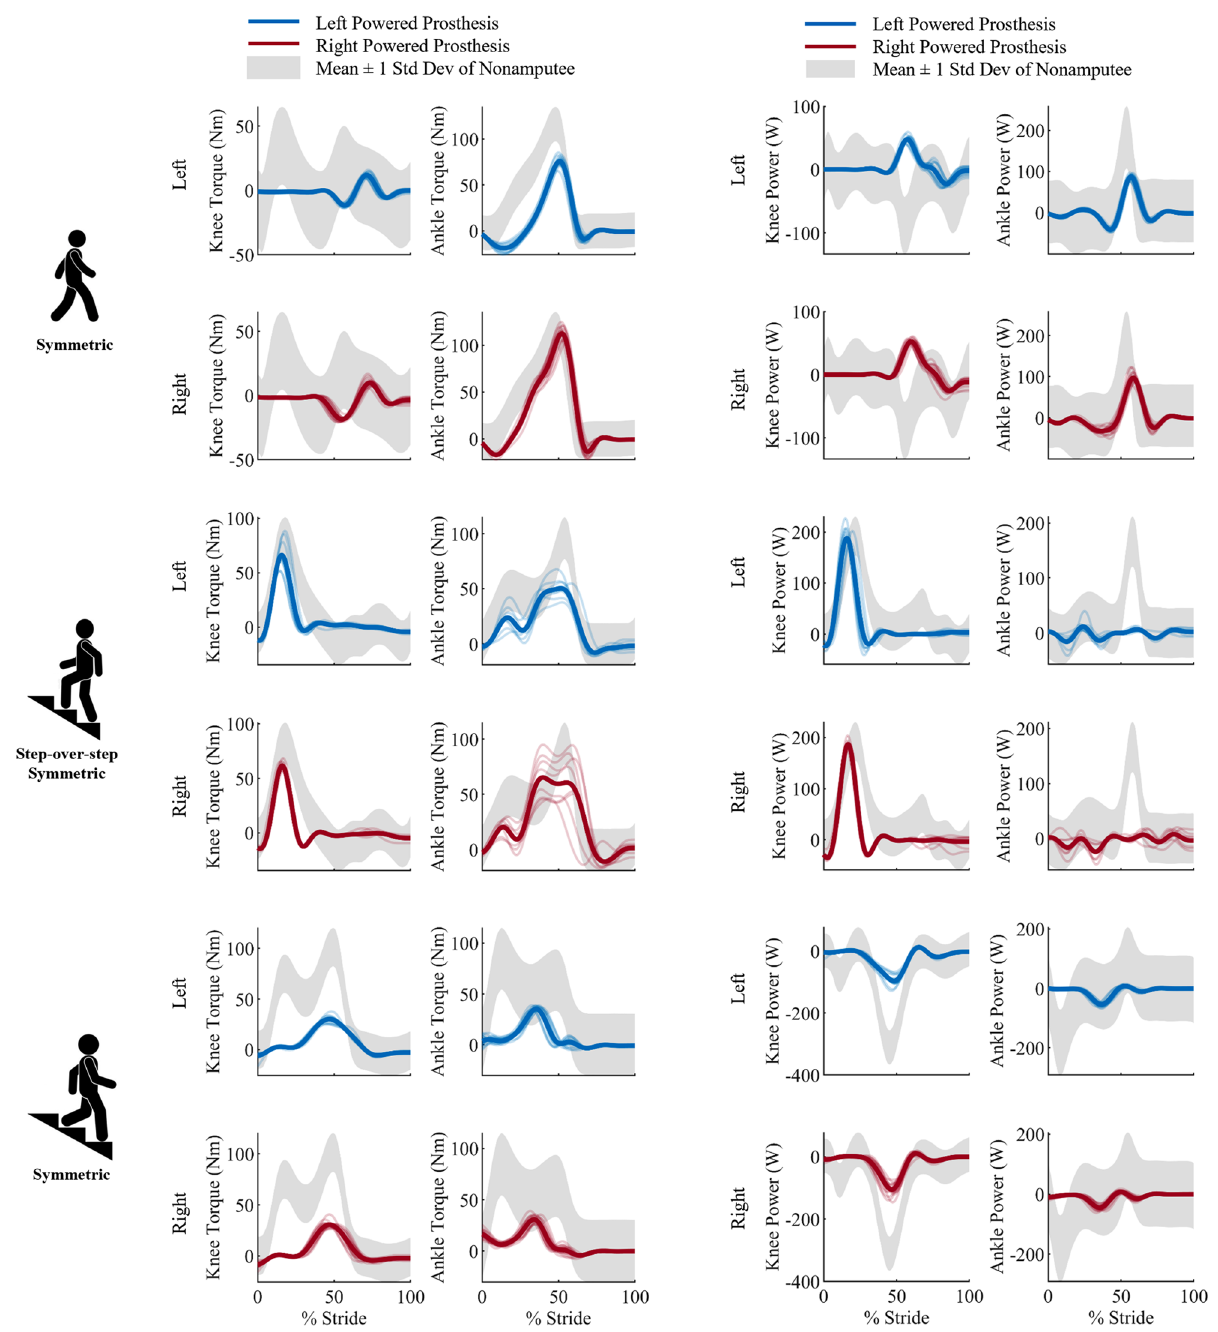
Figure 3. Kinetic profiles of the knee and ankle joints during all ambulation activities. Specifically, the knee and ankle torque profiles and the knee and ankle power profiles (left to right) are shown for both the left side in blue (top row) and right side in red (bottom row) for each ambulation activity. The ambulation activities are walking, stair ascent using the symmetrical step-over-step gait pattern, and stair descent (top to bottom). The powered prostheses torque and power profiles are shown with all strides represented under a bolded average line. The shaded gray region is the standard deviation of the nonamputee reference data 26